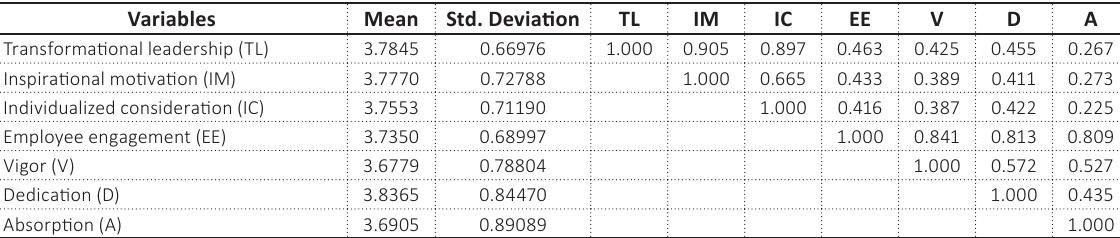
Table 3. Means, SDs and